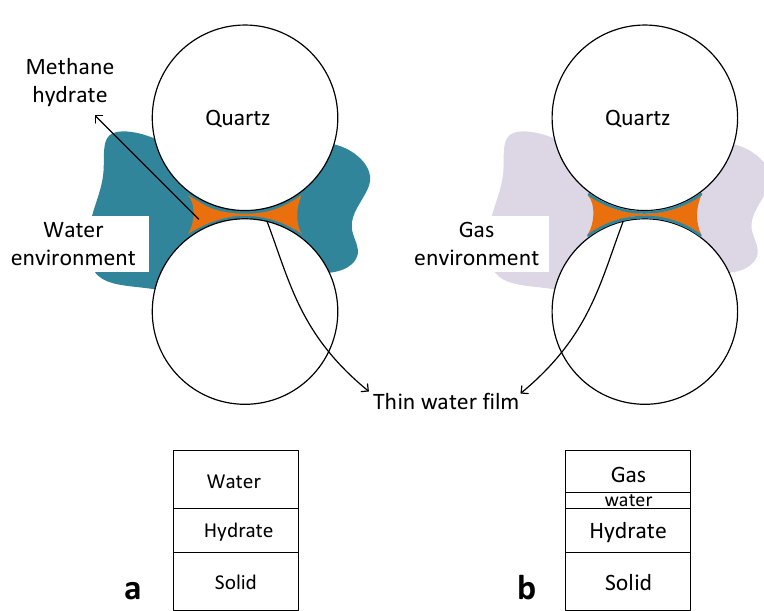
Figure 8. Qualitative description of the three-phase composition of WS MHBS ( a ) and the four-phase composition of GS MHBS ( b ), as well as the developed water film between sand grains and